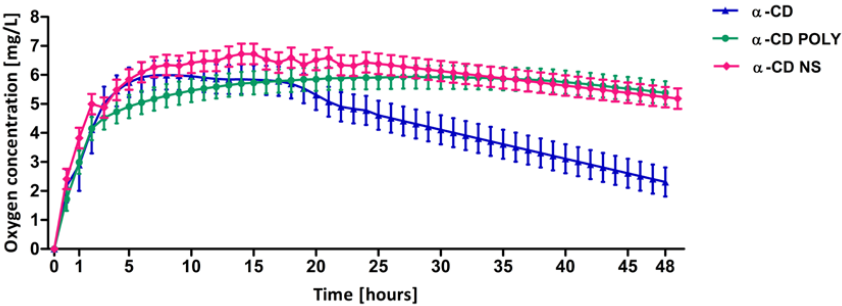
Figure 4. In vitro oxygen release from α-CD-based formulations over time measured by an oximeter. Each point represents the mean ± SD of the three experiments.